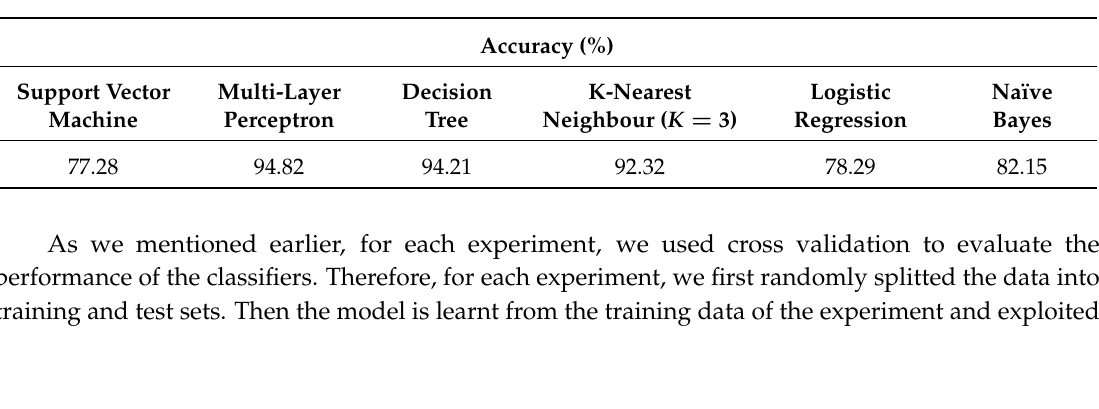
Table 3. MPD Performance for Different